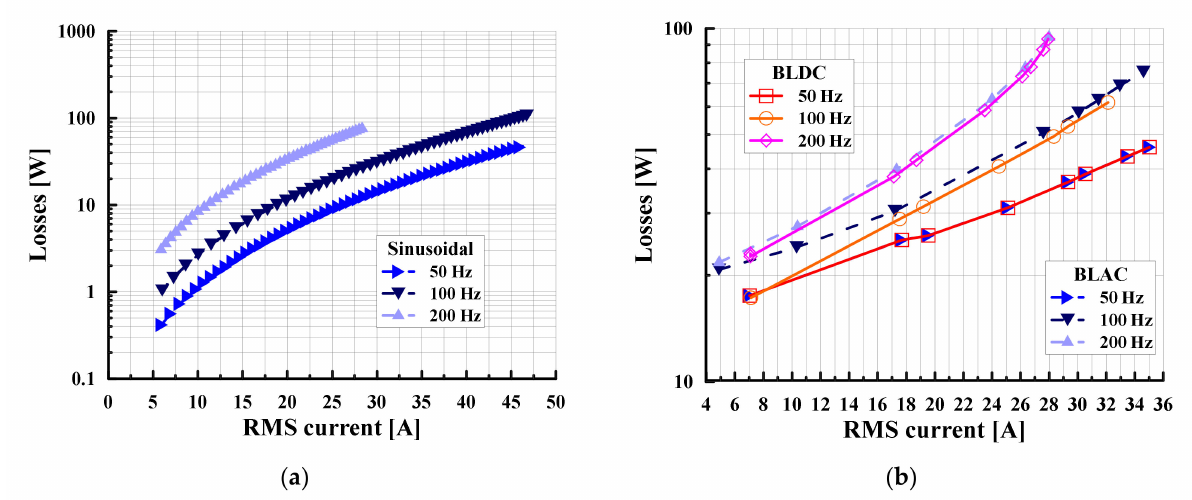
Figure 10. ( a ) The losses in the assembled phase for sinusoidal current; ( b ) stator losses without rotor on modulated